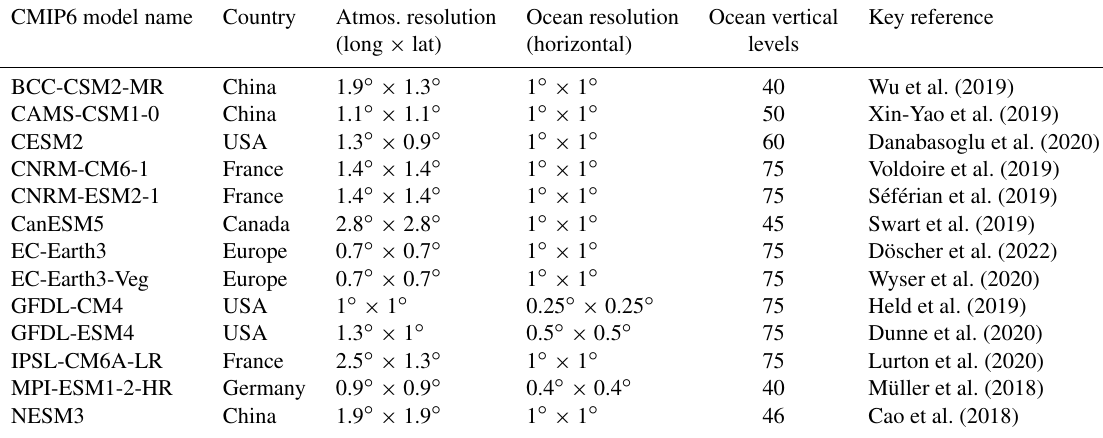
Table 4. Names, resolutions and references for the CMIP6 models used in this